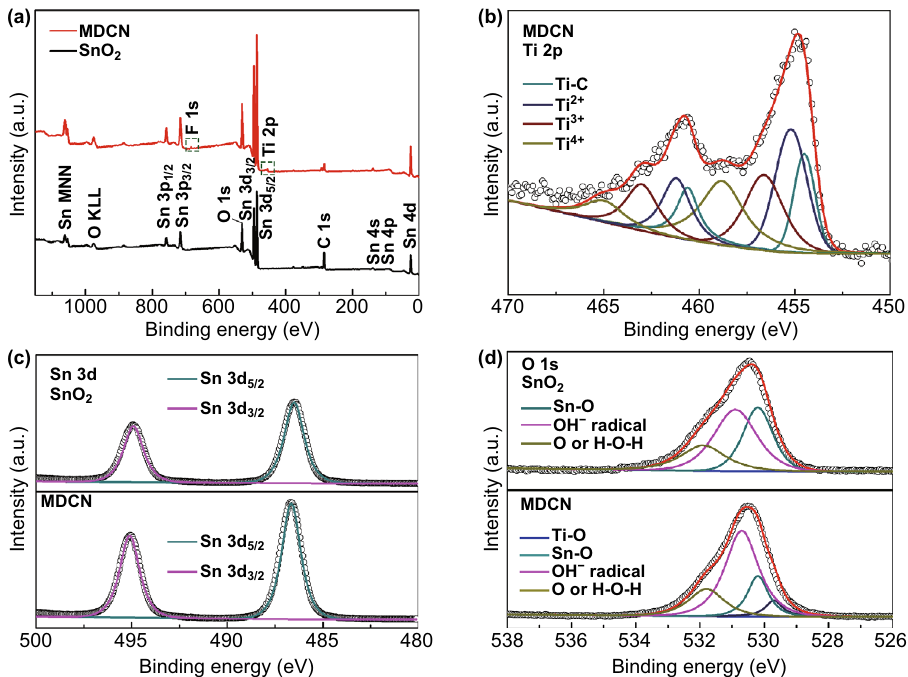
Fig. 3 a XPS survey spectra of SnO 2 and MDCN samples. The high‑resolution XPS spectra of b Ti 2 p for MDCN sample, c Sn 3 d for SnO 2 , and MDCN samples, and d O 1 s for SnO 2 and MDCN